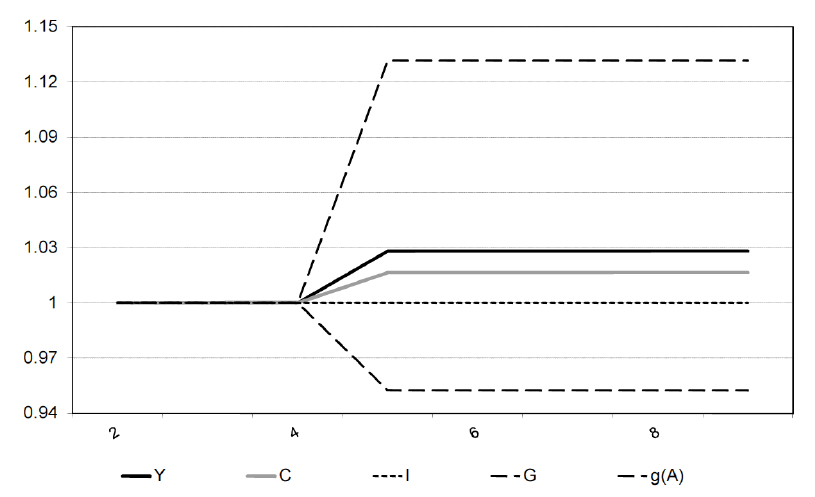
Figure 1. Effect of an increase in the carbon tax on the economy (Case